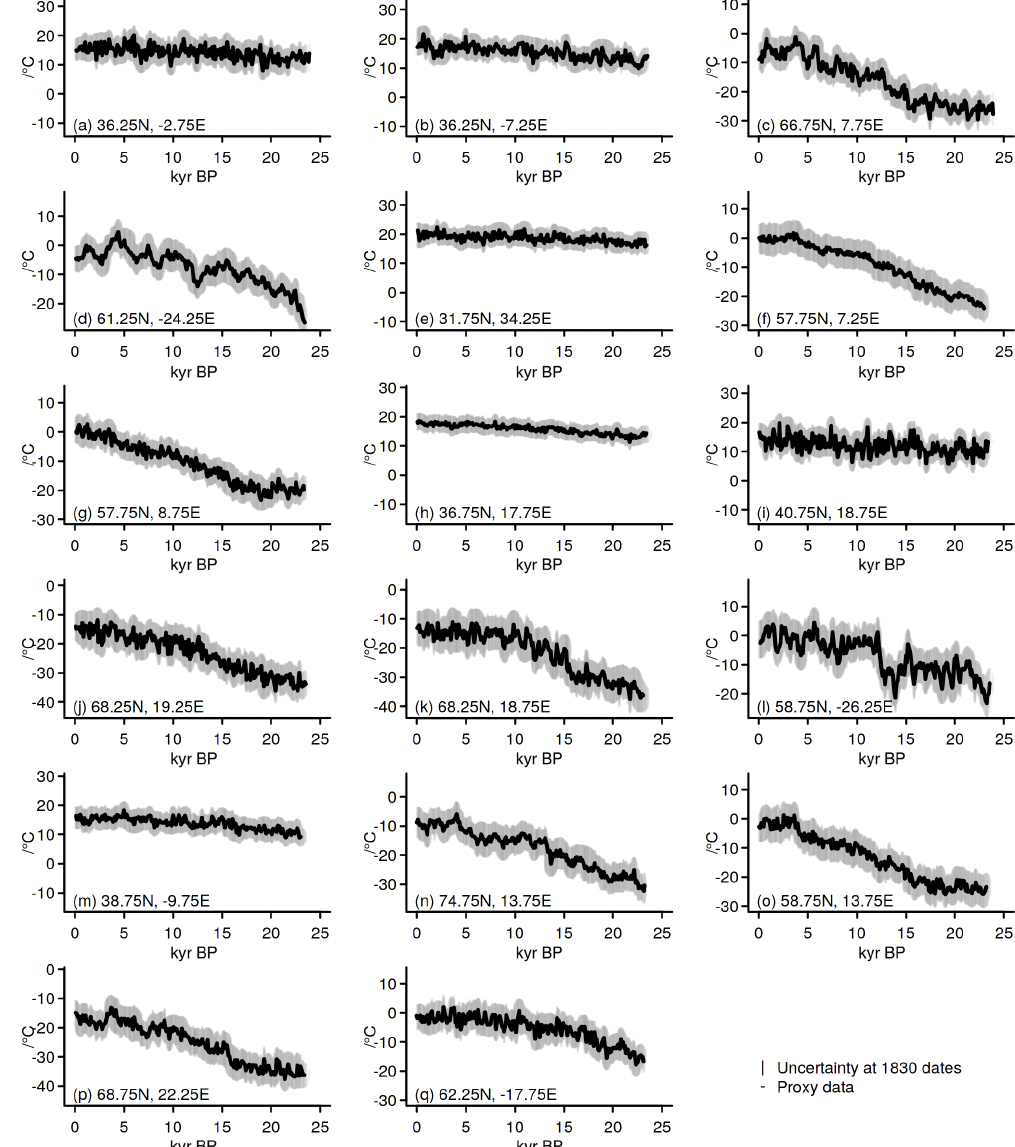
Figure 5. Pseudo-proxy data and assumed uncertainties for the 17 locations in our pseudo-proxy